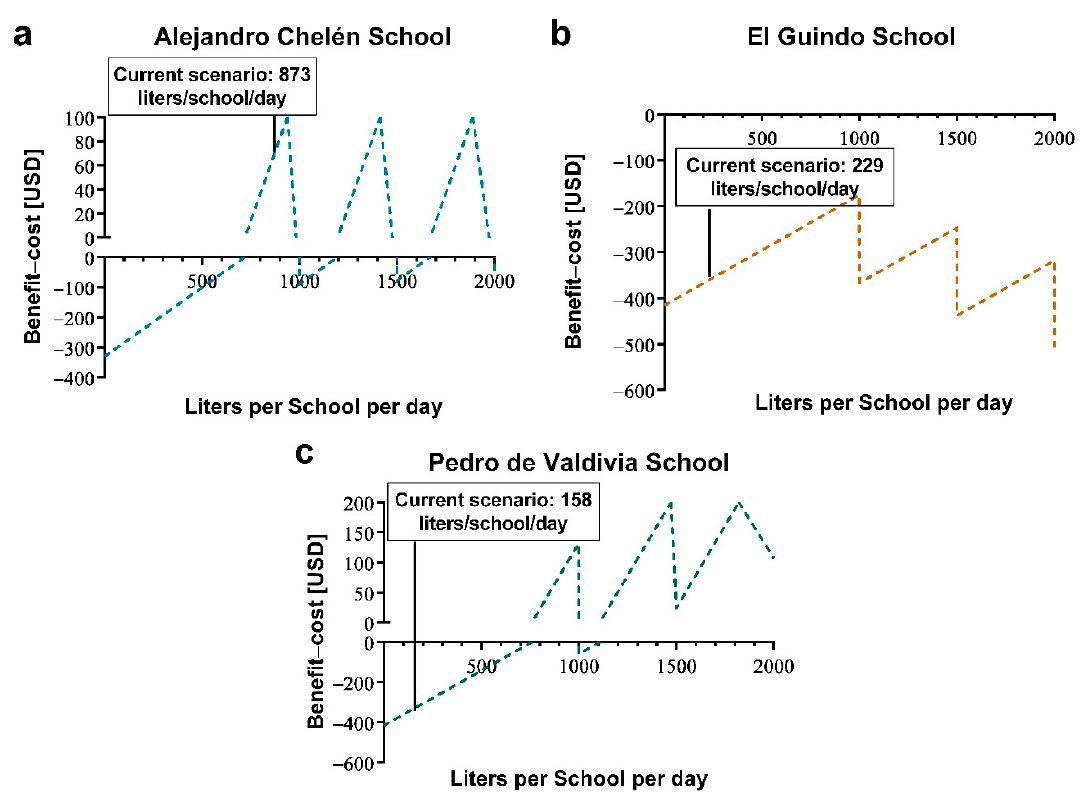
Figure 3. Simplified economic analysis, considering only operating and maintenance costs, and saved water benefits, studied in a range from 0 to 2000 L of greywater treated per school per day at ( a ) Alejandro Chelén School; ( b ) El Guindo School; and ( c ) Pedro de Valdivia School .